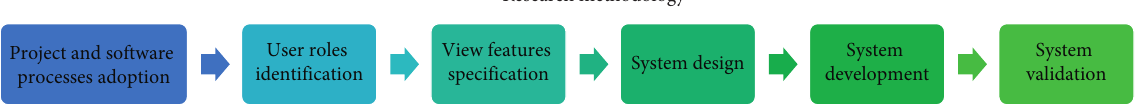
Figure 1: The adopted research methodology steps.